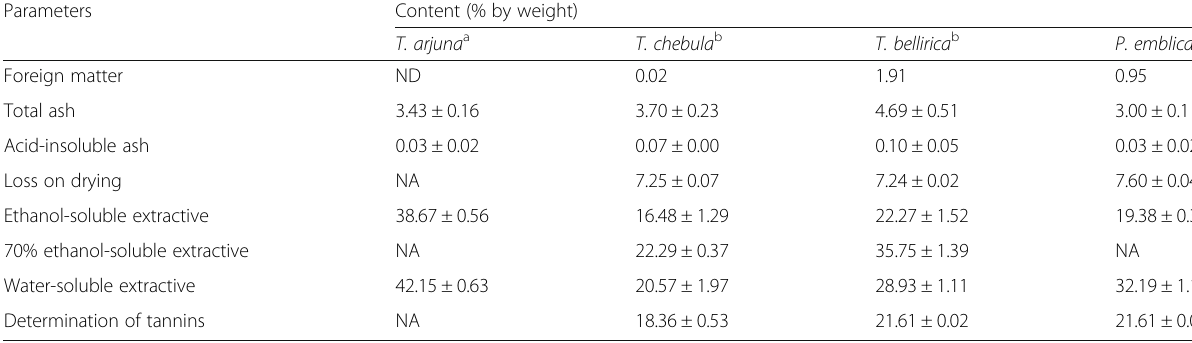
Table 1 Pharmacognostic specification of Terminalia arjuna , Terminalia chebula , Terminalia bellirica , and Phyllanthus emblica